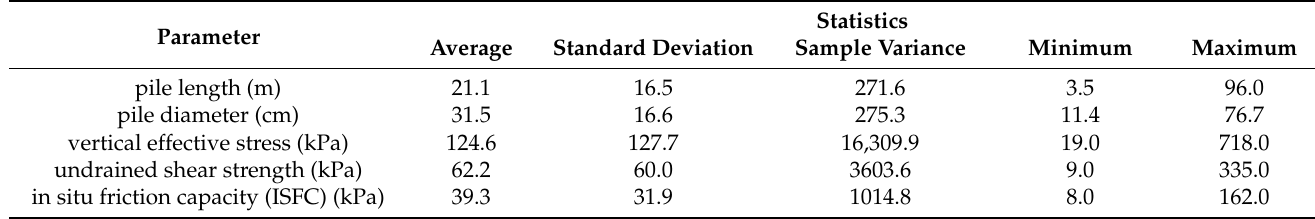
Table 1. Statistics calculated for the